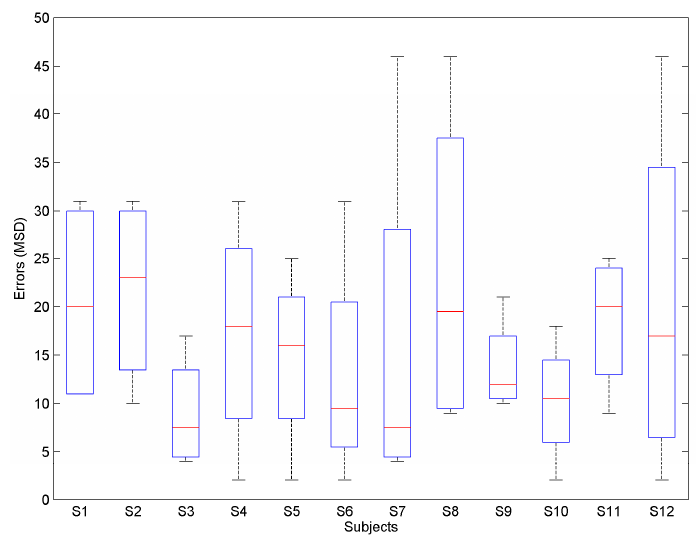
Figure 10. Gesture typing error rate of all subjects.